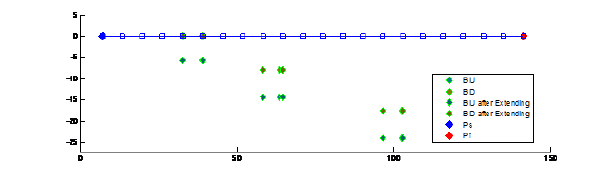
Fig. 7 The transition results of upper and lower limits